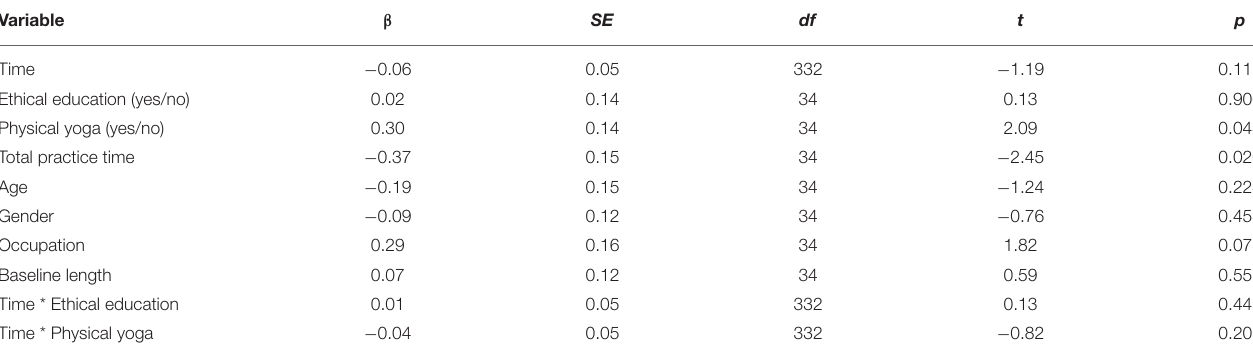
TABLE 7 | Multilevel regression estimates for stress scores as dependent variable and time, effective component, age, gender, and baseline length as predictors.